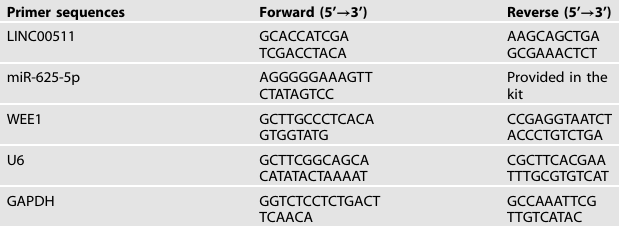
Table 1. Primer sequences for genes used in